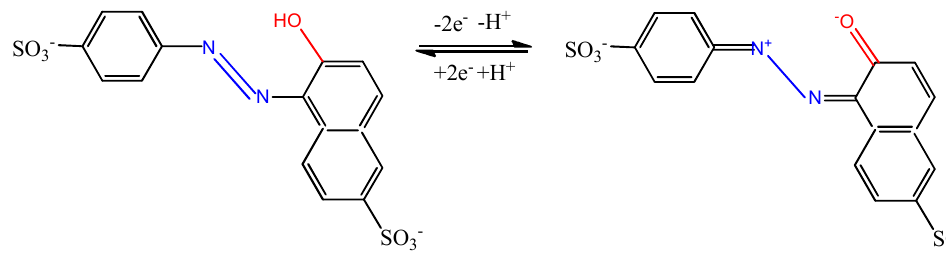
Scheme 1. Sunset Yellow Electrochemical Oxidation Mechanism .